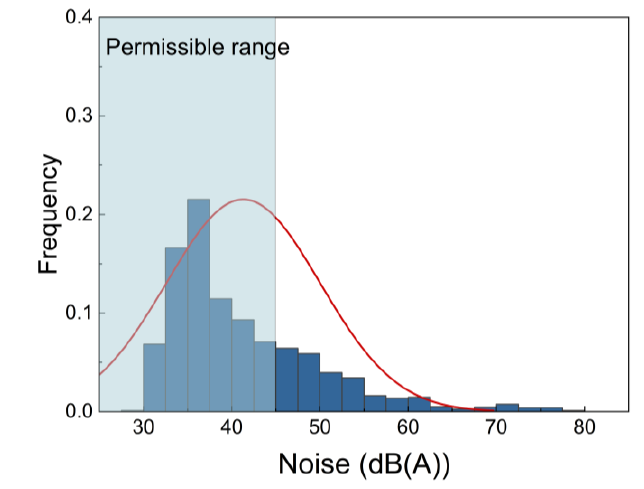
Figure 4. Histograms of noise SPL.